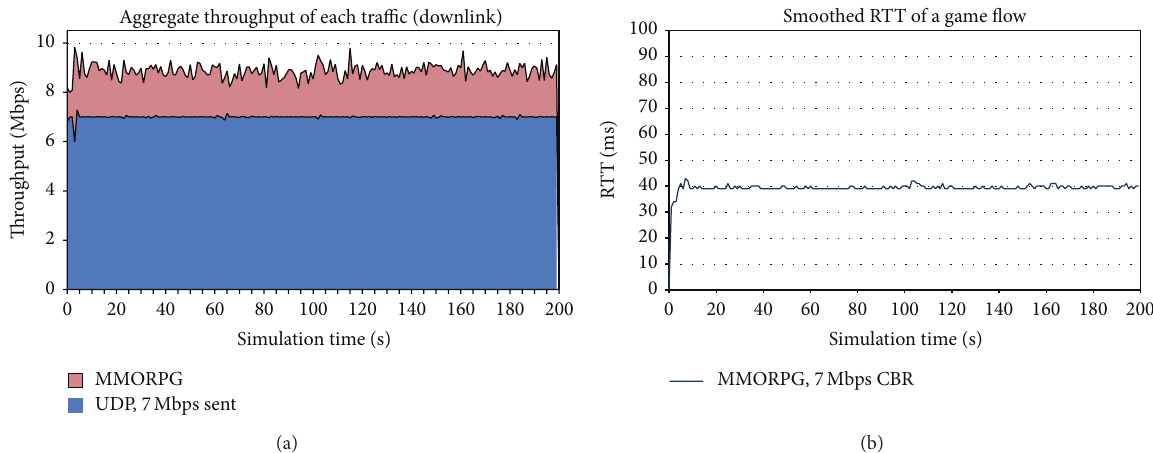
Figure 11: Coexistence of 100 MMORPG flows and 7Mbps of UDP CBR traffic: (a) received throughput in the downlink by each traffic and (b) smoothed RTT of one of the game flows.